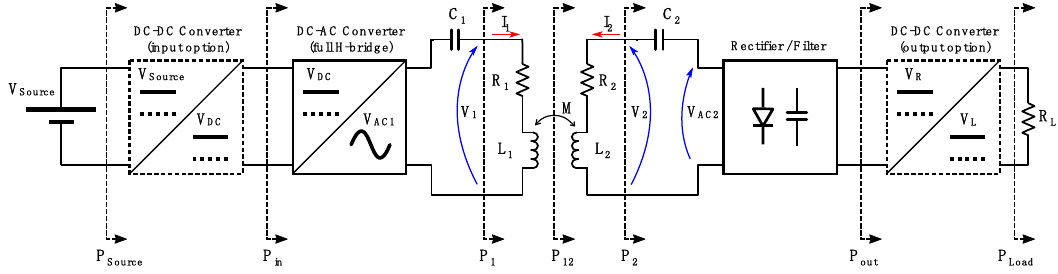
Figure 5. Typical series-series (SS)-compensated WPT system architecture, sectioned at power transfer boundaries.